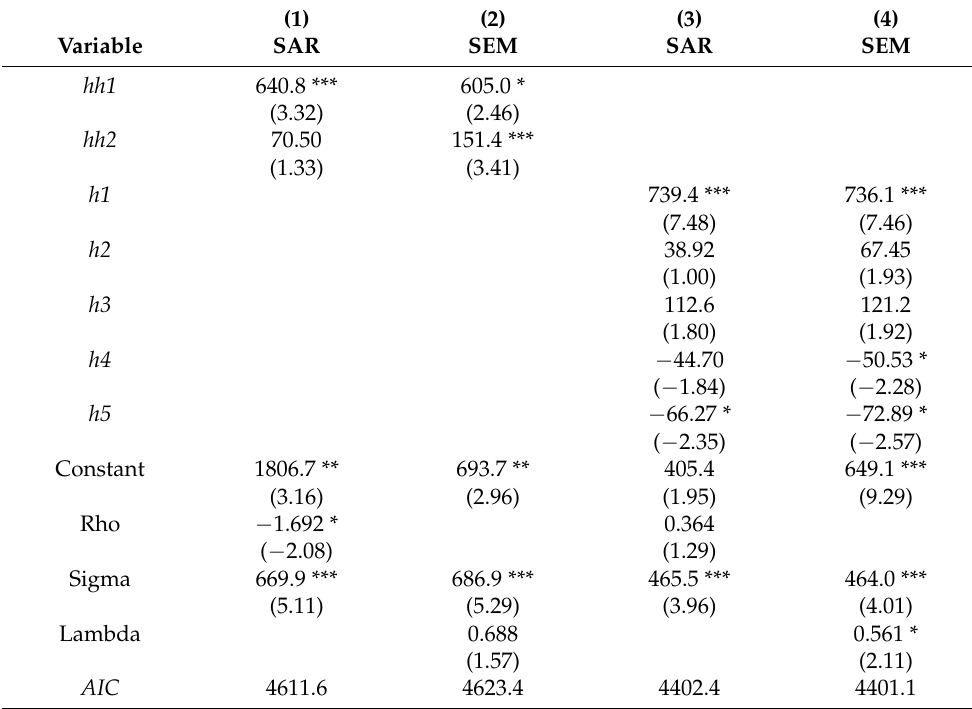
Table 5. Spatial autoregressive and error